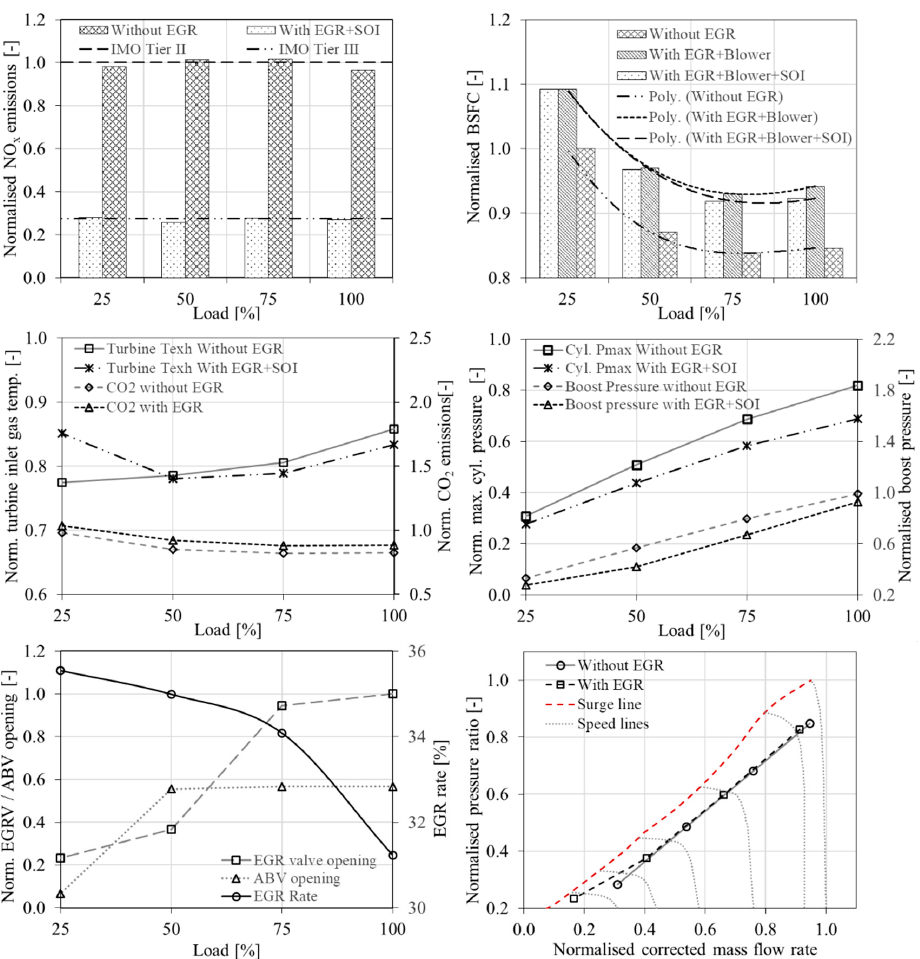
Figure 4. Predicted engine parameters with EGR and ABP systems operation under steady state conditions (case studies 1–4 and 5–8).